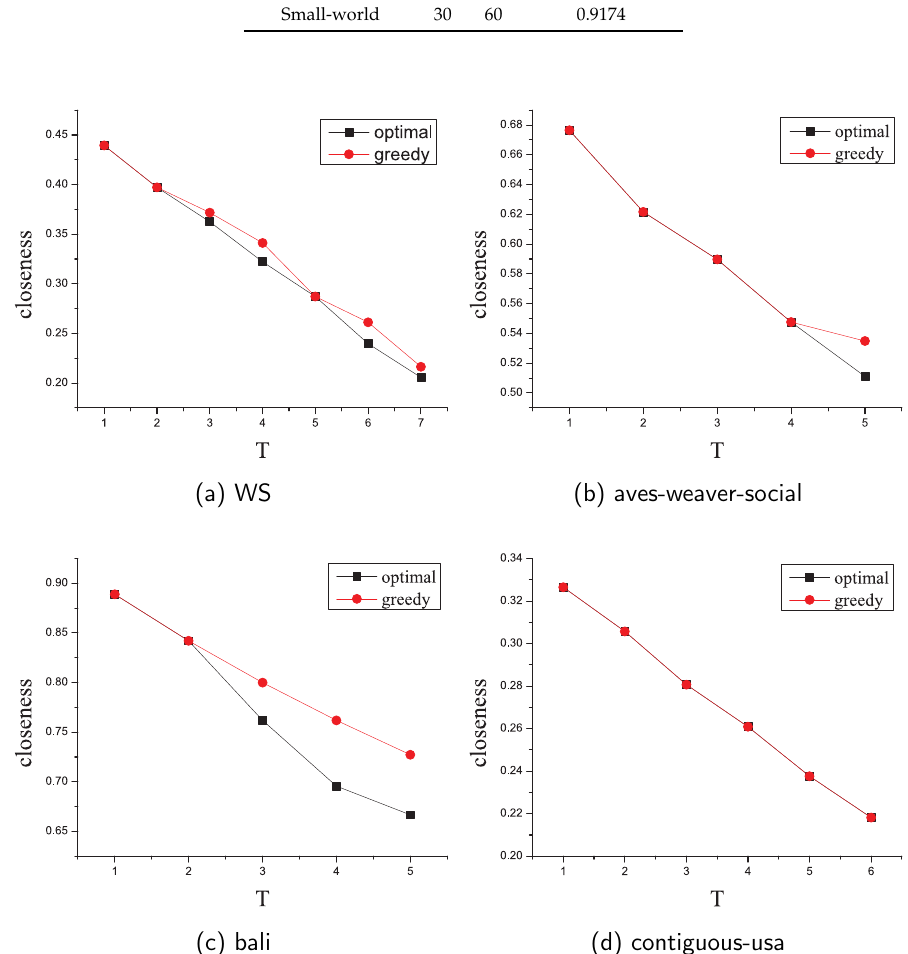
Figure 5. The comparison of the optimal and greedy closeness value